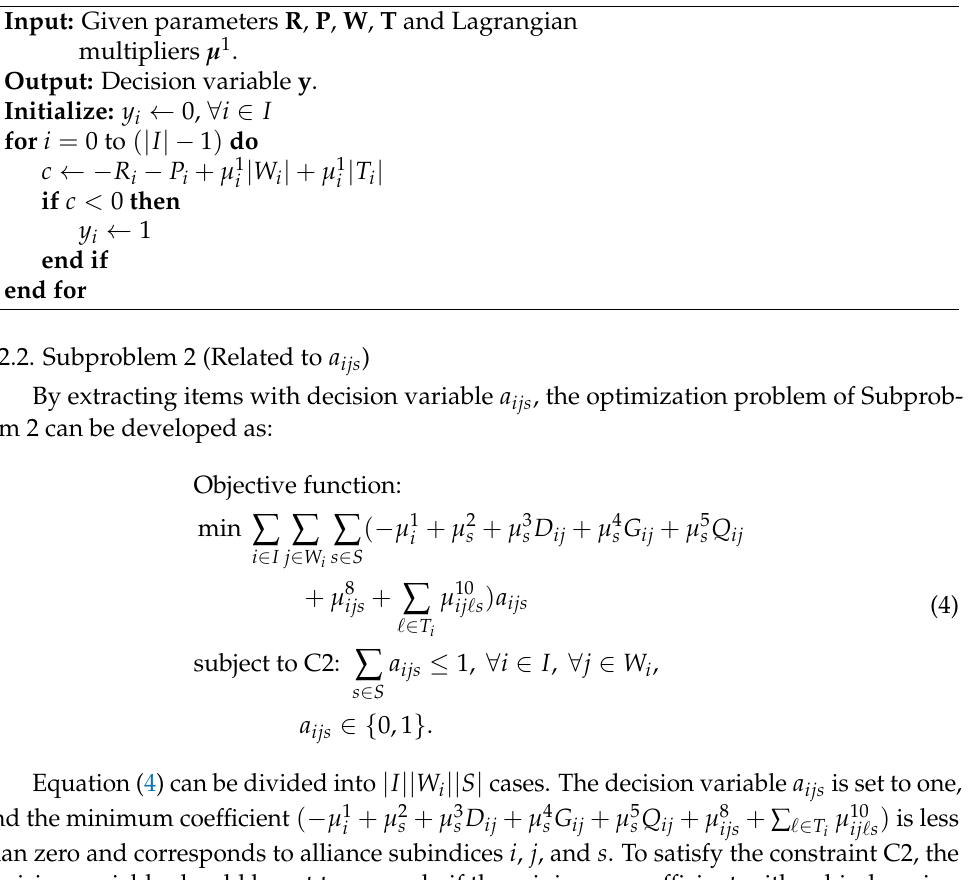
Algorithm 1 Subproblem 1.